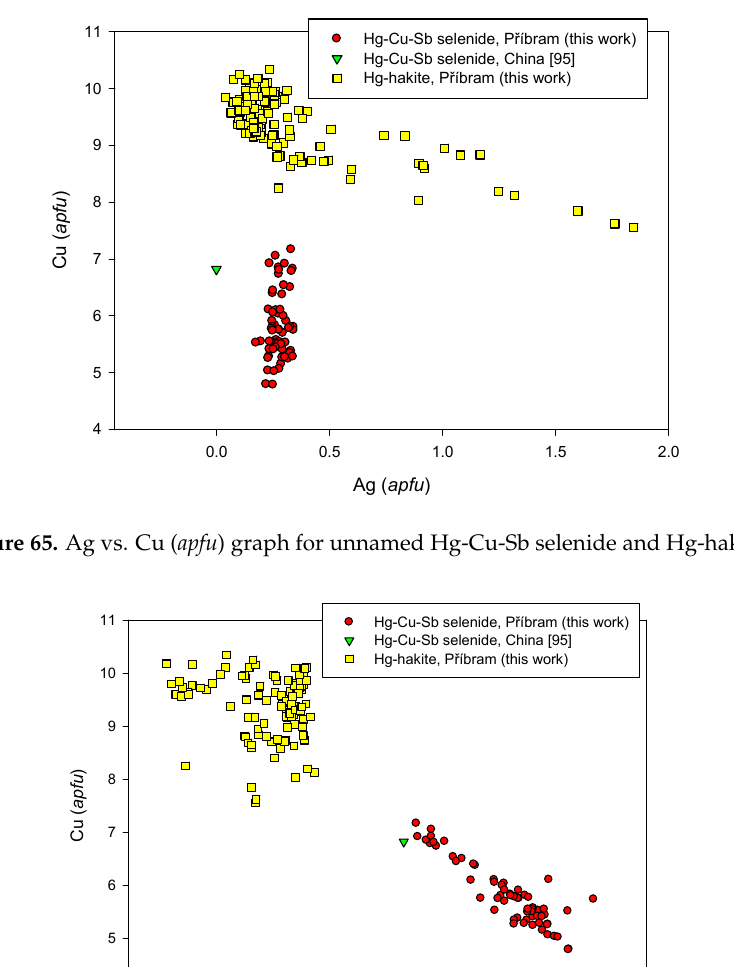
Figure 67. Hg ( apfu ) vs. vacancies pfu graph for unnamed Hg-Cu-Sb selenide and Hg-hakite; vacancies were calculated as 12-(Cu + Ag + Tl + Hg + Fe + Zn + Cd).